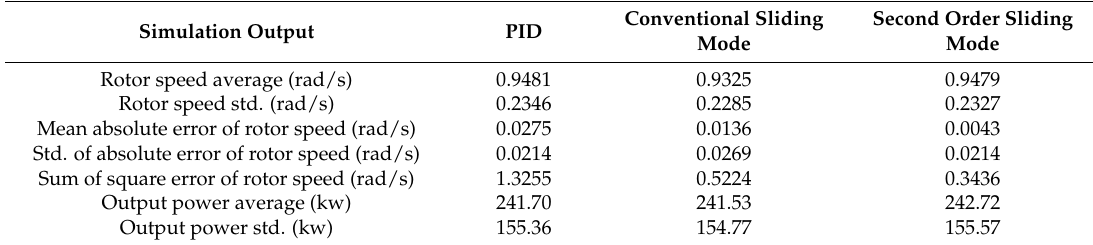
Table 3. Simulation results of turbine rotor speed, speed error and output power.